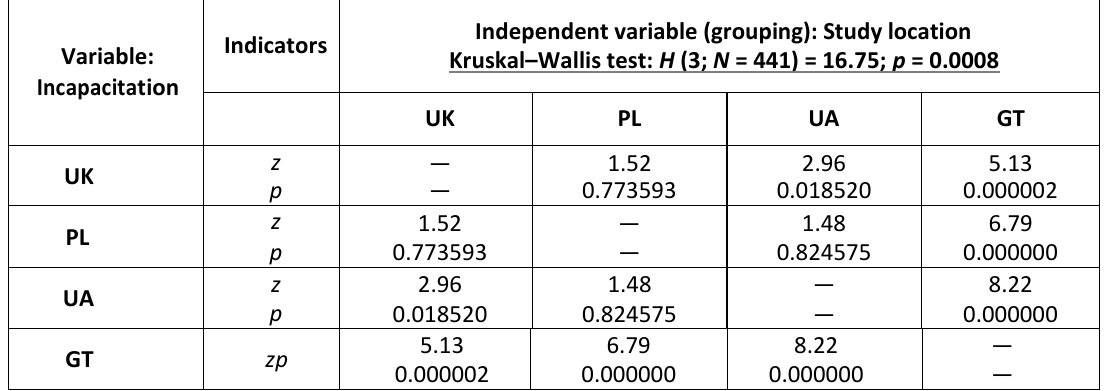
Table 9. Post-hoc tests for incapacitation